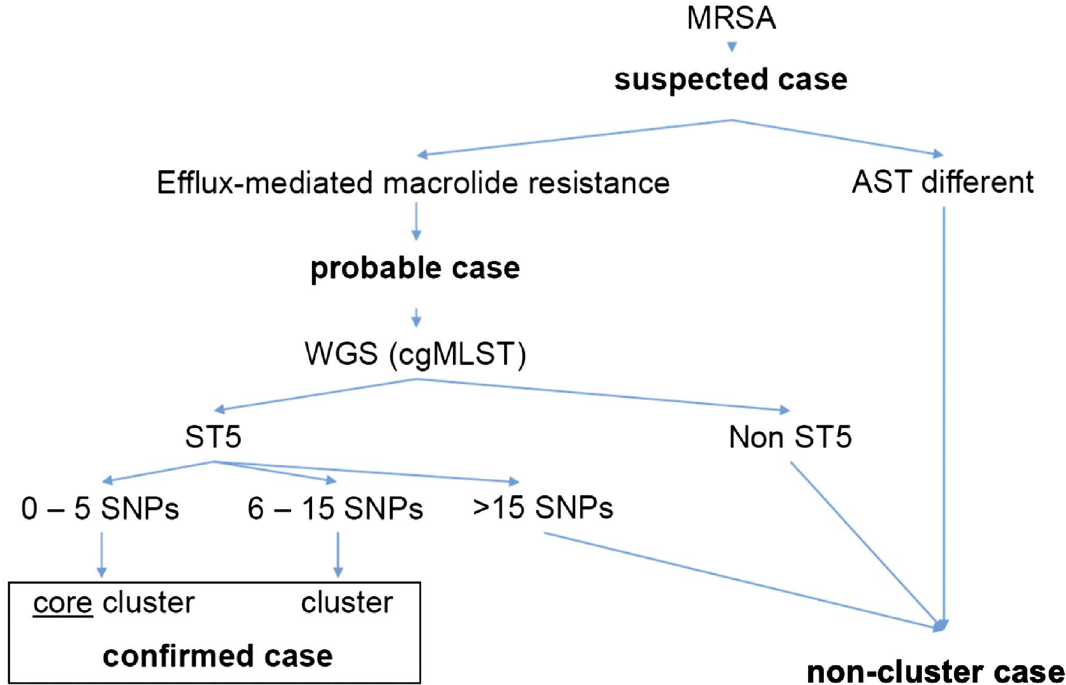
Figure 1. Case definitions based on microbiological results used in this study. AST antimicrobial susceptibility testing, cgMLST core genome multi-locus sequence typing, WGS whole-genome sequencing, MRSA